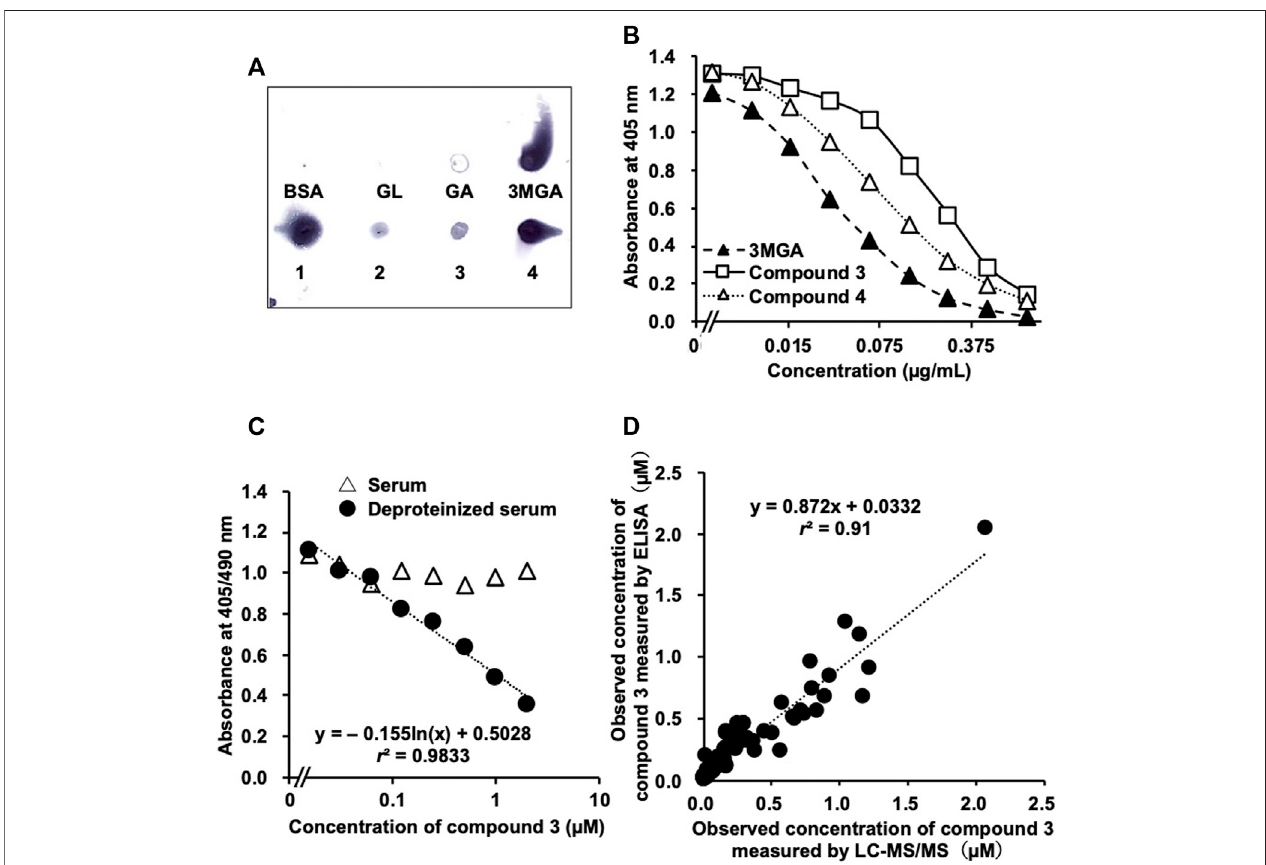
FIGURE 4 | Development of enzyme-linked immunosorbent assay (ELISA) system to measure concentrations of 3 in human serum samples using anti-18 β - glycyrrhetyl-3- O -glucuronide (3MGA)-monoclonal antibody (mAb). (A) Dot-blot analysis of glycyrrhizin (GL) metabolites using anti-3MGA-mAb. GL metabolites and bovine serum albumin (BSA, 1 µg each) were spotted onto polyethersulfone membrane and stained using an anti-3MGA-mAb. (B) Competitive ELISA using an anti- 3MGA-mAb for 3MGA, 3 , and 4 in aqueous solution was performed (C) Standard solutions of 3 (15.6 nM – 2 µM) in normal human serum were prepared. Serum samples were deproteinized by treating with 80% ethanol, followed by centrifugation, and the supernatants were dried up under reduced pressure. Standard lines between absorbance and concentrations of compound 3 are shown (D) Accuracy of ELISA system in measuring concentrations of 3 in human serum samples using anti-3MGA-mAb. Human serum samples were deproteinized, and concentration of 3 was measured using ELISA system. Samples with observed values higher than 400 nM were diluted appropriately with H 2 O to set detectable range from 10 to 400 nM. Values were compared with the result of liquid chromatography-tandem mass spectrometry (LC-MS/MS) analysis from our previous study (Takahashi K, 2019). Signi fi cant relationship was observed between the values observed using ELISA and LC-MS/MS values ( r 2 (cid:2) 0.91).